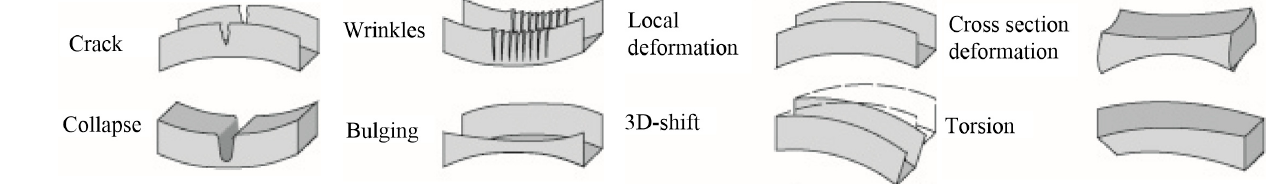
Figure 2. Specific problems for forming curved profiles [5,24,25,27].